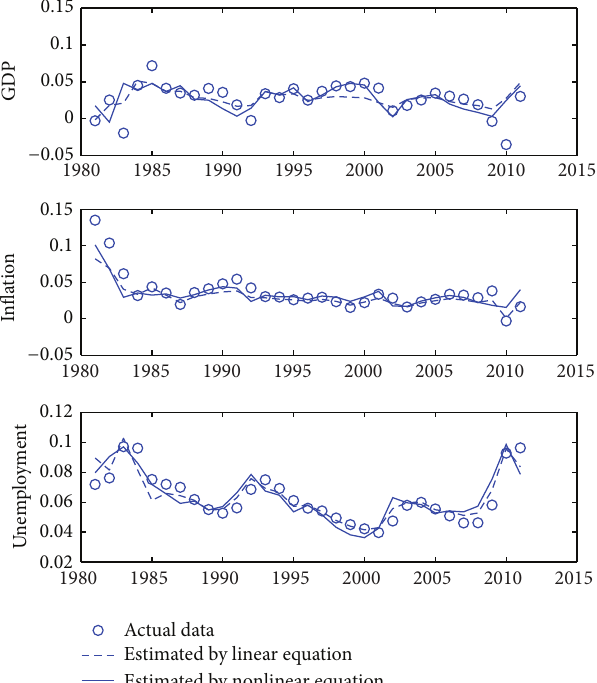
Figure 4: The actual and estimated data of the GDP, inflation and unemployment by the linear and nonlinear models with ℎ = 0.85